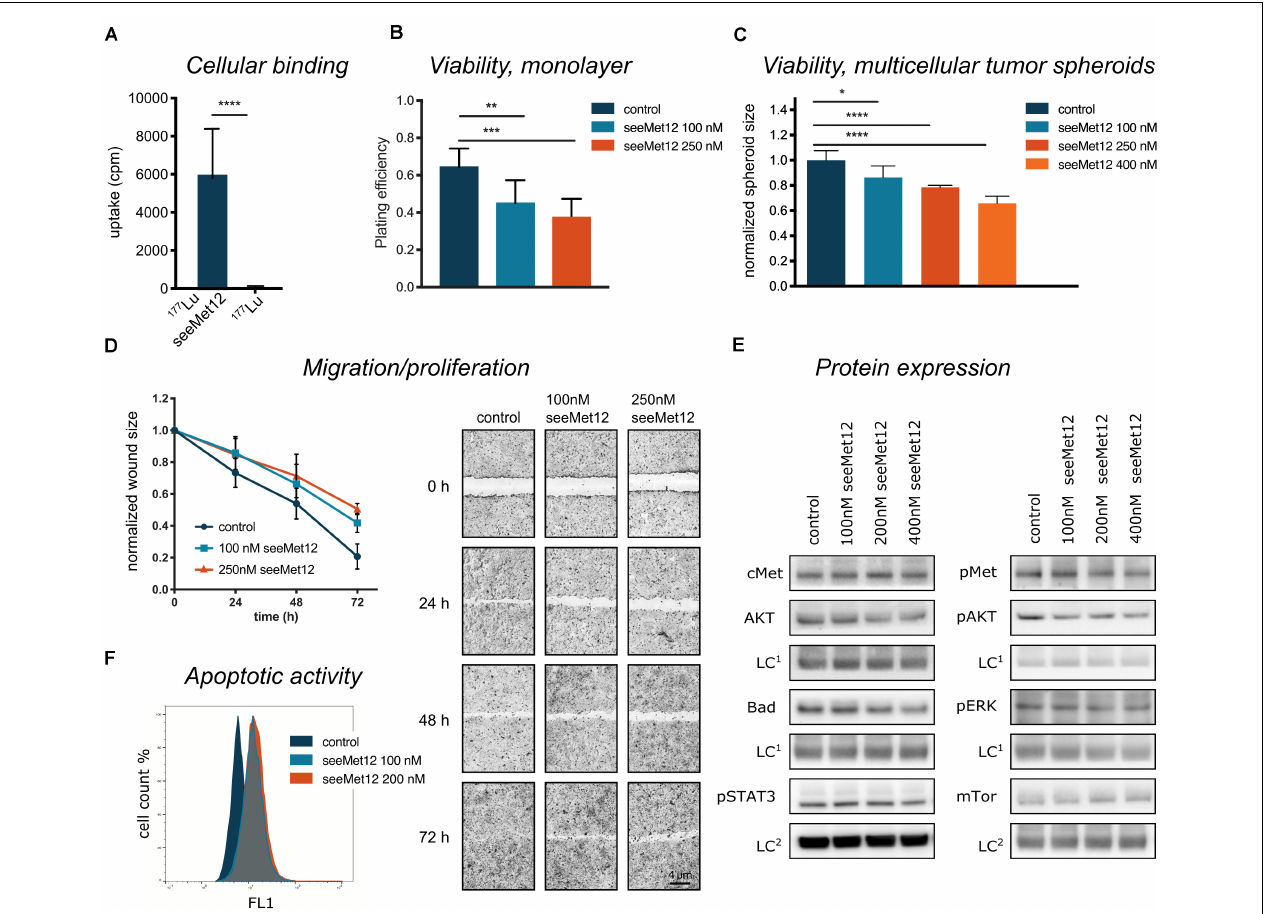
FIGURE 2 | Characterization of seeMet 12 monotherapy in HT-29 cells. (A) Cellular binding assessed by radioimmunoassay comparing 177 Lu-radiolabeled seeMet 12 and free radionuclide 177 Lu. n = 3, Error bars represent SD. (B) Viability assessed in a 2D model (clonogenic survival), displayed as plating efficiency after treatment with 100 and 250 nM seeMet 12. N = 4, Error bars represent SD. (C) Viability assessed in a 3D model (tumor spheroids), displaying multicellular tumor spheroid size at day 18 after treatment with 100, 250, and 400 nM seeMet 12. n = 10 for control, n = 5 for treatment groups. Error bars represent SD. (D) Cellular migration/proliferation assessed with wound healing/scratch assay treated with 100 and 250 nM seeMet 12. Images of the scratch were taken at experiment start (0 h) and after 24, 48, and 72 h. N = 4, Error bars represent SD. Representative images from the HT-29 migration assay treated with seeMet 12, images were taken with 4 × magnification. (E) Western blot analysis of cMet, AKT, Bad and pSTAT, pMet, pAKT, pERK and mTor 72 h after treatment with 100, 200, or 400 nM seeMet 12. The representative images were taken with the same exposure times across the entire image, however, different for different membrane fragments of the assessed proteins. The corresponding loading control (LC 1 = Sodium Potassium ATPase; LC 2 = beta actin) of the same membrane is displayed below the membrane of the investigated protein. (F) Representative histogram for flow cytometric assessment of caspase 3 and 7 (apoptotic activity) in control, 100 and 200 nM seeMet 12 treated monolayer cells. Considered to be statistically significant * p < 0.05, ** p < 0.01, *** p < 0.001, **** p <